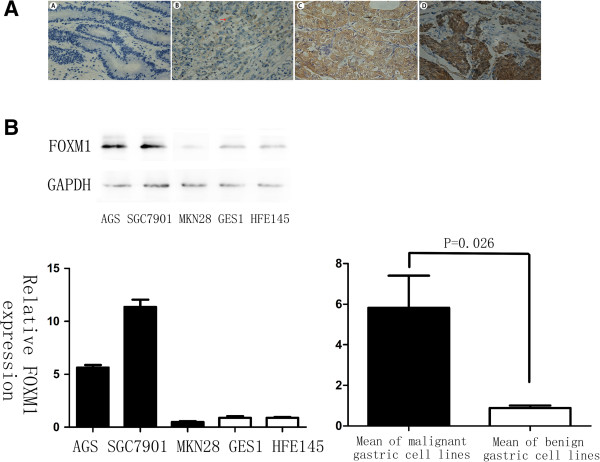
FOXM1 expression in gastric cancer tissues and cell lines. (A) Immunohistochemical staining for FOXM1 antibody in gastric cancer tissue: (A). Negative staining for FOXM1, ×400; (B). Weakly positive staining for FOXM1, ×400; (C). Moderately positive staining for FOXM1, ×400; (D). Strongly positive staining for FOXM1, ×400. FOXM1 expression was stained in the nuclei or cytoplasm of cells. Red arrow: cytoplasm stained; Black arrow: nuclei stained. (B) Different expressions of FOXM1 in gastric cancer cell lines: SGC-7901, AGS and MKN-28; normal gastric epithelium cell lines: GES-1 and HFE-145. There was a significant difference in FOXM1 expression between the benign and malignant gastric cell groups (P = 0.026).